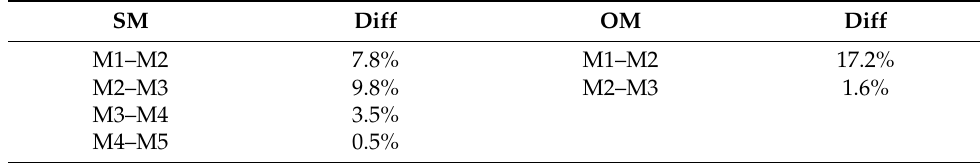
Table 7. Differences in the average torque between the